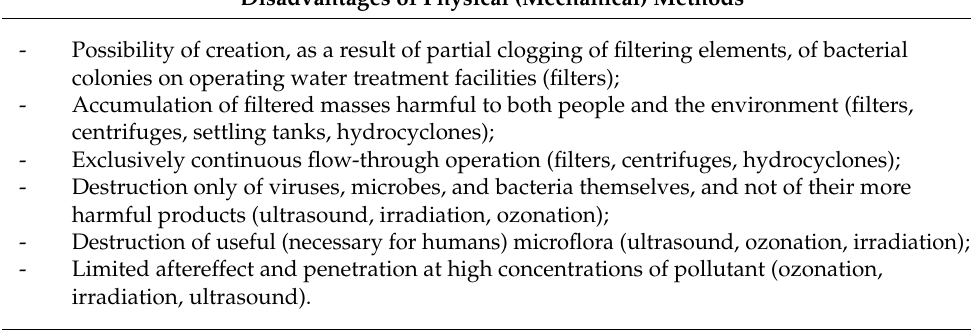
Table 2. Types of technological disadvantages according to different methods of wastewater